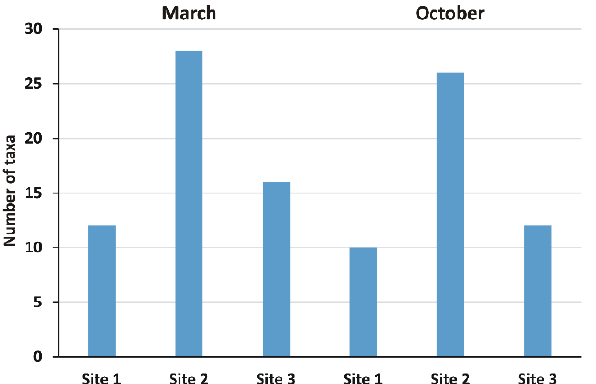
Figure 2. Number of non-diatom algal taxa observed in biofilm in March and in October. Site 1 (Villadossola), Site 2 (Bosco Tenso), Site 3